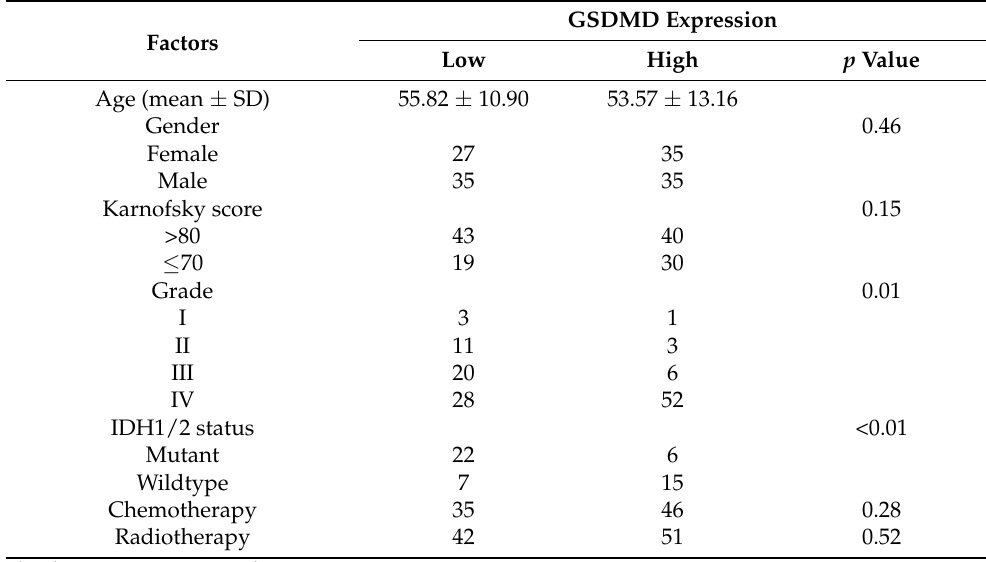
Table 3. Comparison of clinical characteristics in different GSDMD expression groups among glioma